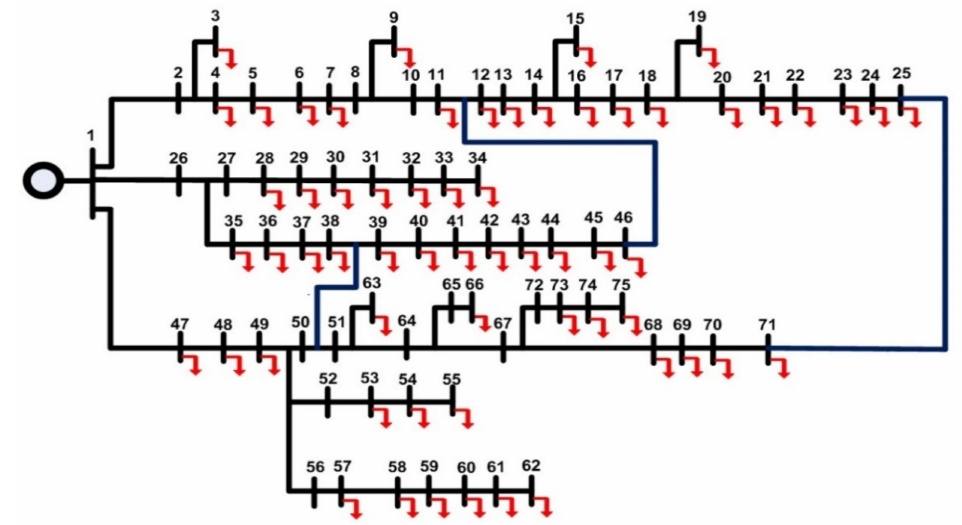
Figure 5. Extended NUST mesh-configured 75-bus microgrid